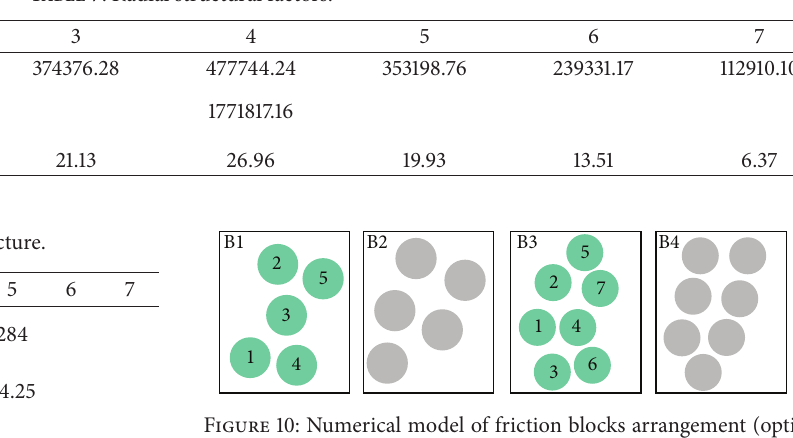
Figure 10: Numerical model of friction blocks arrangement (opti- mized: B1 and B3, nonoptimized: B2 and